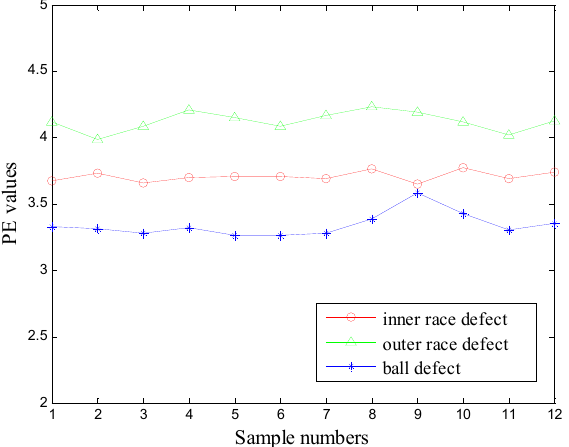
Figure 28. The permutation entropies of the proposed approach.